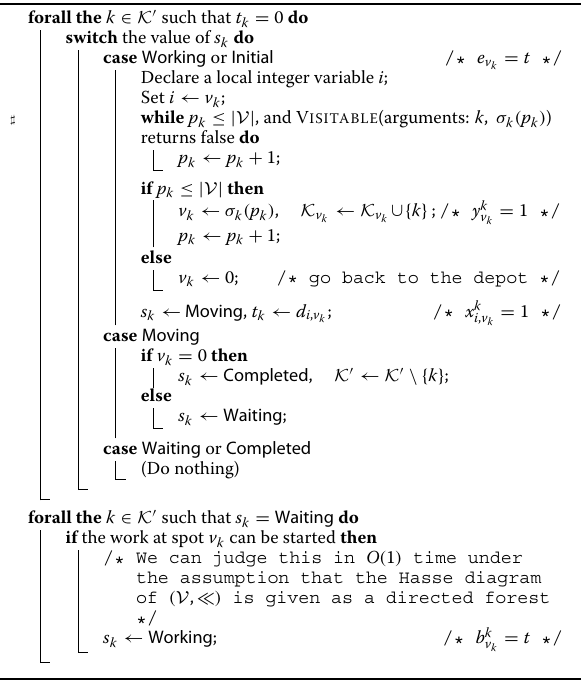
Algorithm 1: Subroutine for determining next action